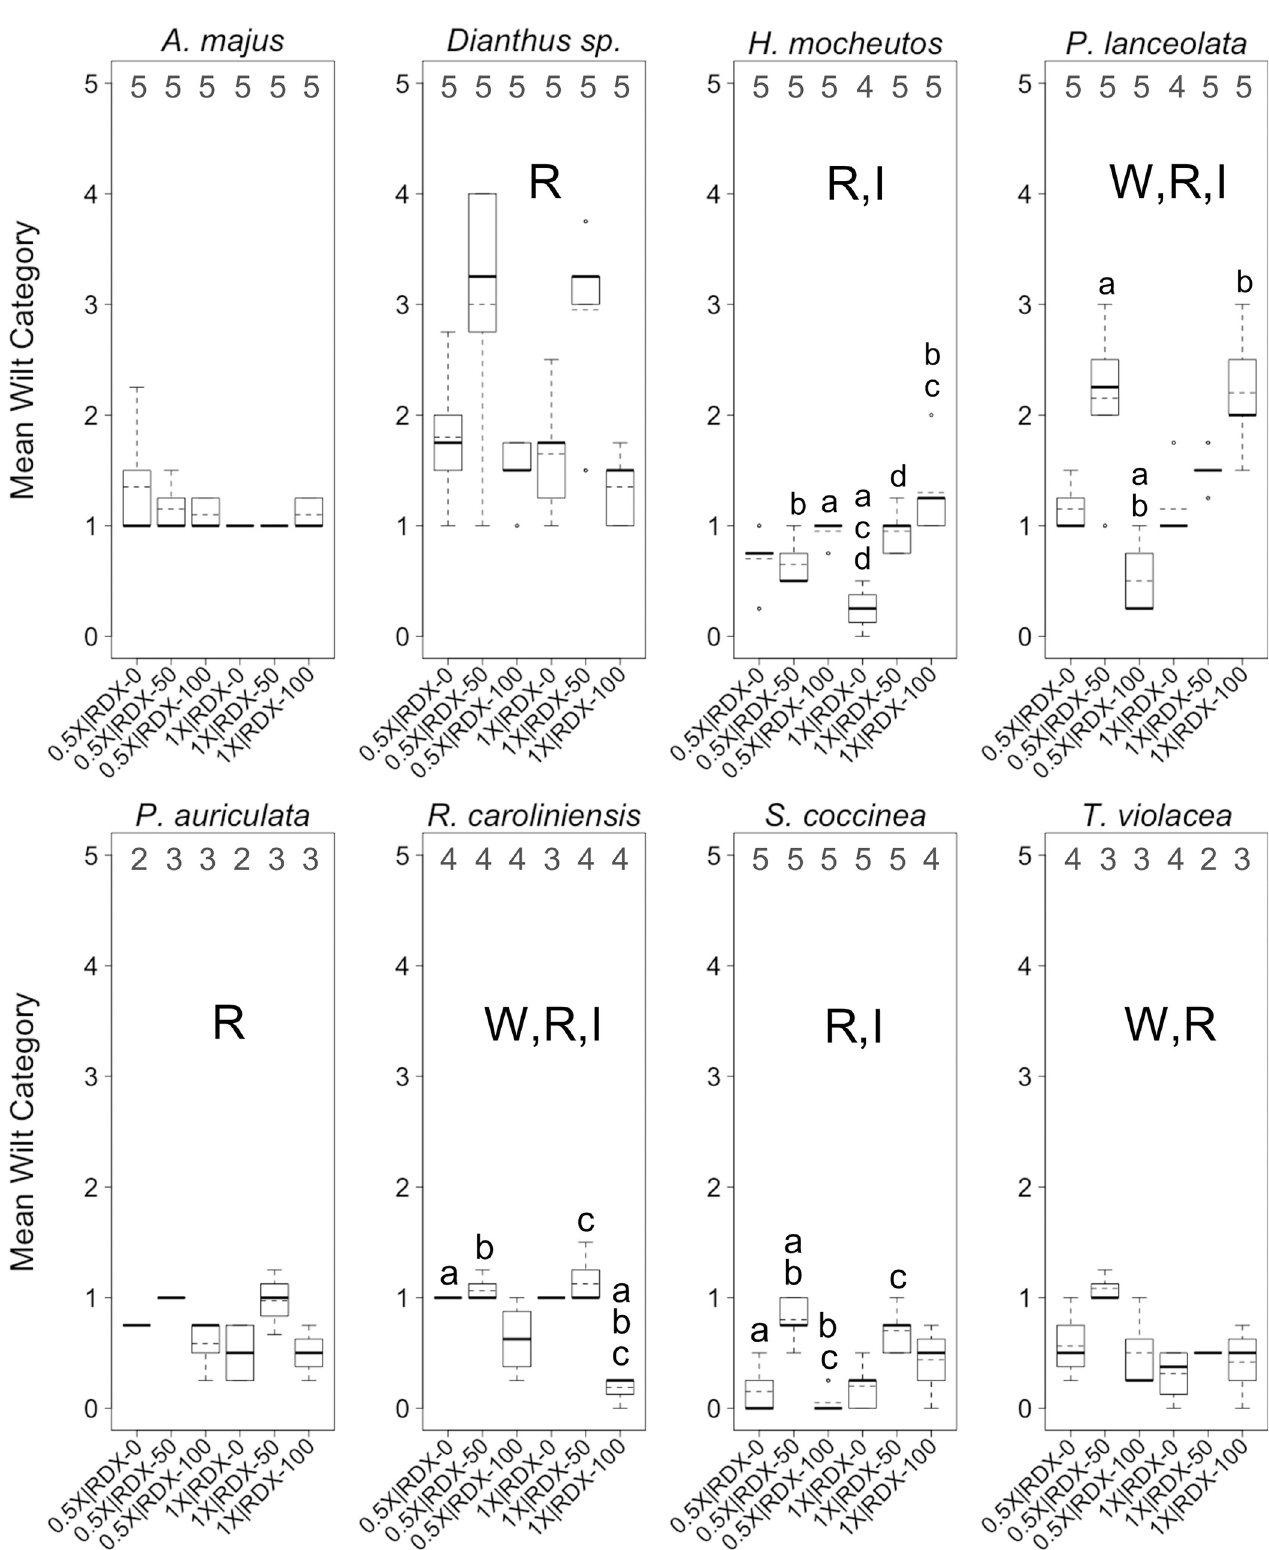
Fig 4. Wilting levels in greenhouse trials. Boxplots of mean wilting levels per plant across eight plant species. Plants were reared in a greenhouse under different combinations of two factors, water-resourcing level (1X and 0.5X) and soil RDX concentration (0, 50, and 100 ppm). Boxplots include median (bold